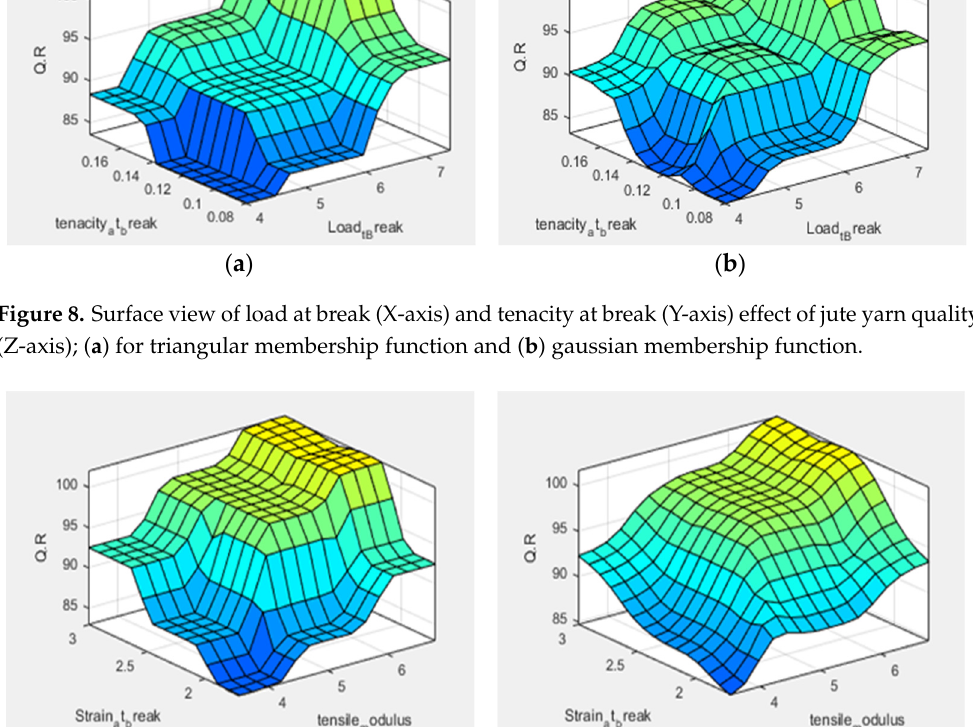
Figure 9. Surface view of tensile modulus (X-axis) and strain at break (Y-axis) effect on jute yarn quality (Z-axis); ( a ) for triangular membership function and ( b ) gaussian membership function.